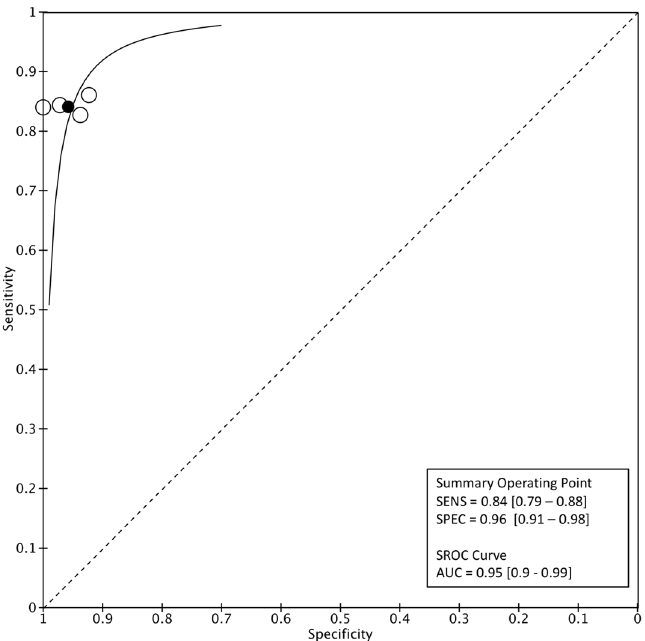
Figure 4. Level-1 classification algorithm for PD: Summary ROC plot with mean operating sensitivity and specificity point.